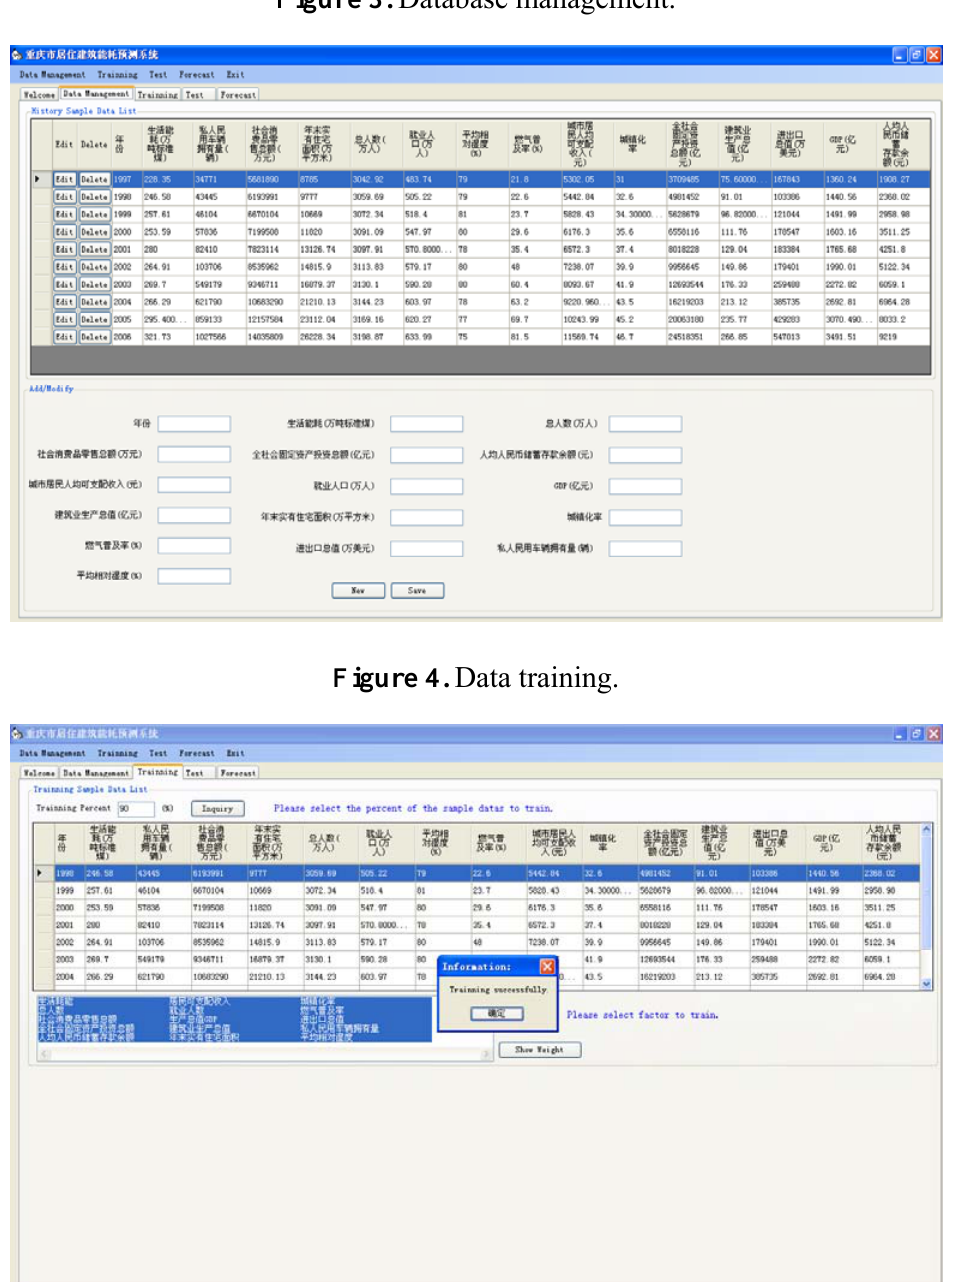
Figure 3. Database management.